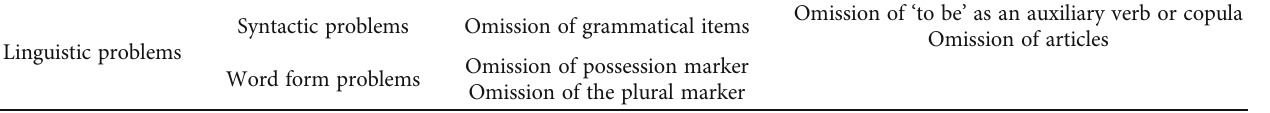
Table 8: Linguistic and semantic problems of English translation of the Vakil bath